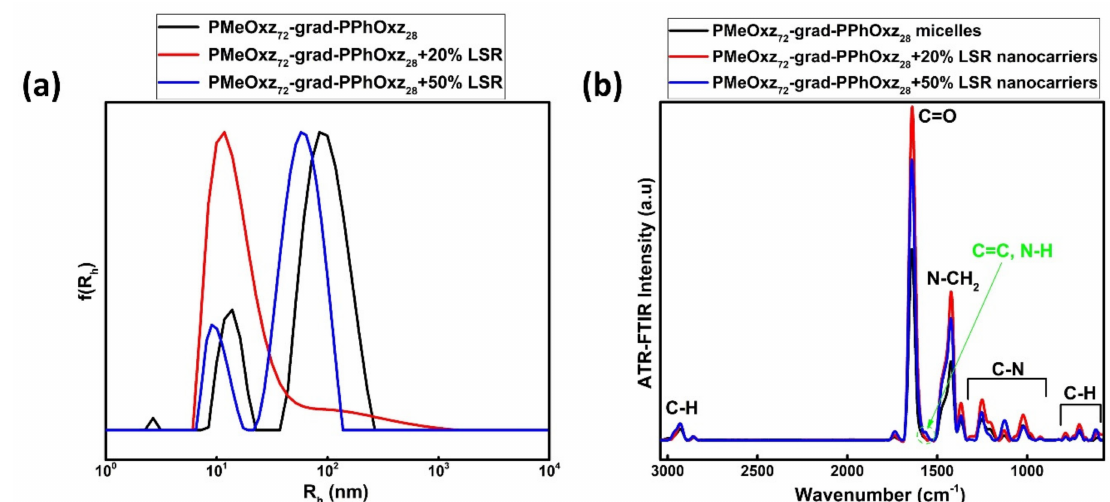
Figure 2. Comparative ( a ) size distributions from Contin of PMeOxz 72 -grad-PPhOxz 28 nanoassemblies and LSR-loaded PMeOxz 72 -grad-PPhOxz 28 nanocarriers at 90 ◦ in aqueous solutions, ( b ) ATR-FTIR spectra of PMeOxz 72 -grad-PPhOxz 28 nanoassemblies and LSR-loaded PMeOxz 72 -grad-PPhOxz 28 nanocarriers in aqueous solutions prepared by the